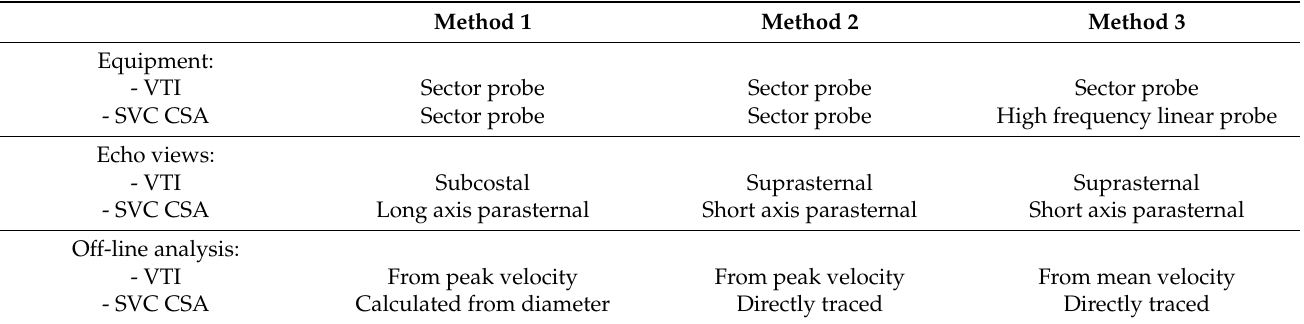
Table 1. Characteristics of the three methods of SVC flow